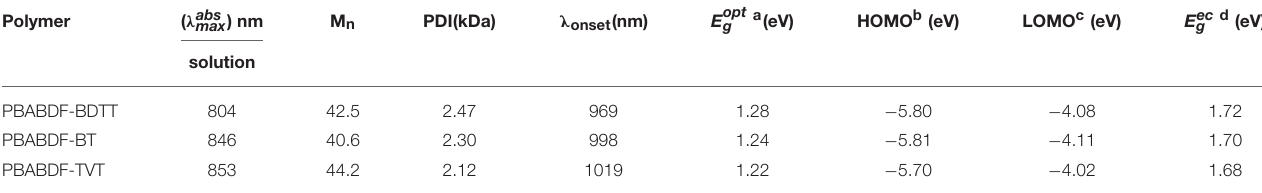
TABLE 1 | Molecular Weight, optical and electrochemical properties of polymers.